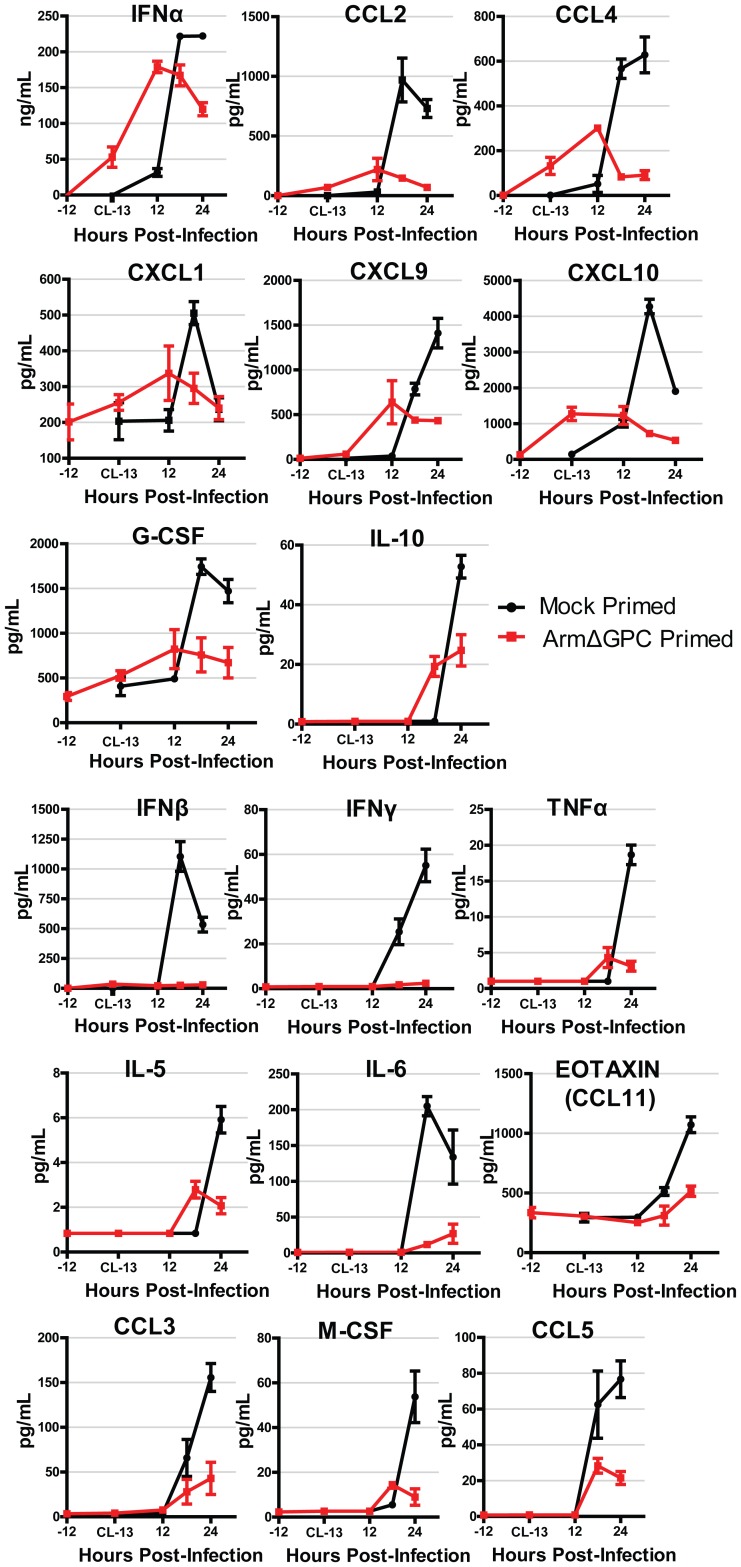
Cytokine responses during primed and mock primed Cl13 infected mice.C57Bl6/J mice (n = 4/group) were mock (PBS) or ArmΔGPC (2×106,i.v.) primed and 12 hours later infected with Cl13 (2×106,i.v.). Standard ELISAs (IFNα and IFNβ) and multiplex ELISAs were performed on serum samples taken at the indicated time points. Red and black lines correspond to values from ArmΔGPC or mock, respectively, primed mice. Data for cytokines that were not detected by the multiplex ELISA and those for which there was no discernible difference were not graphed.